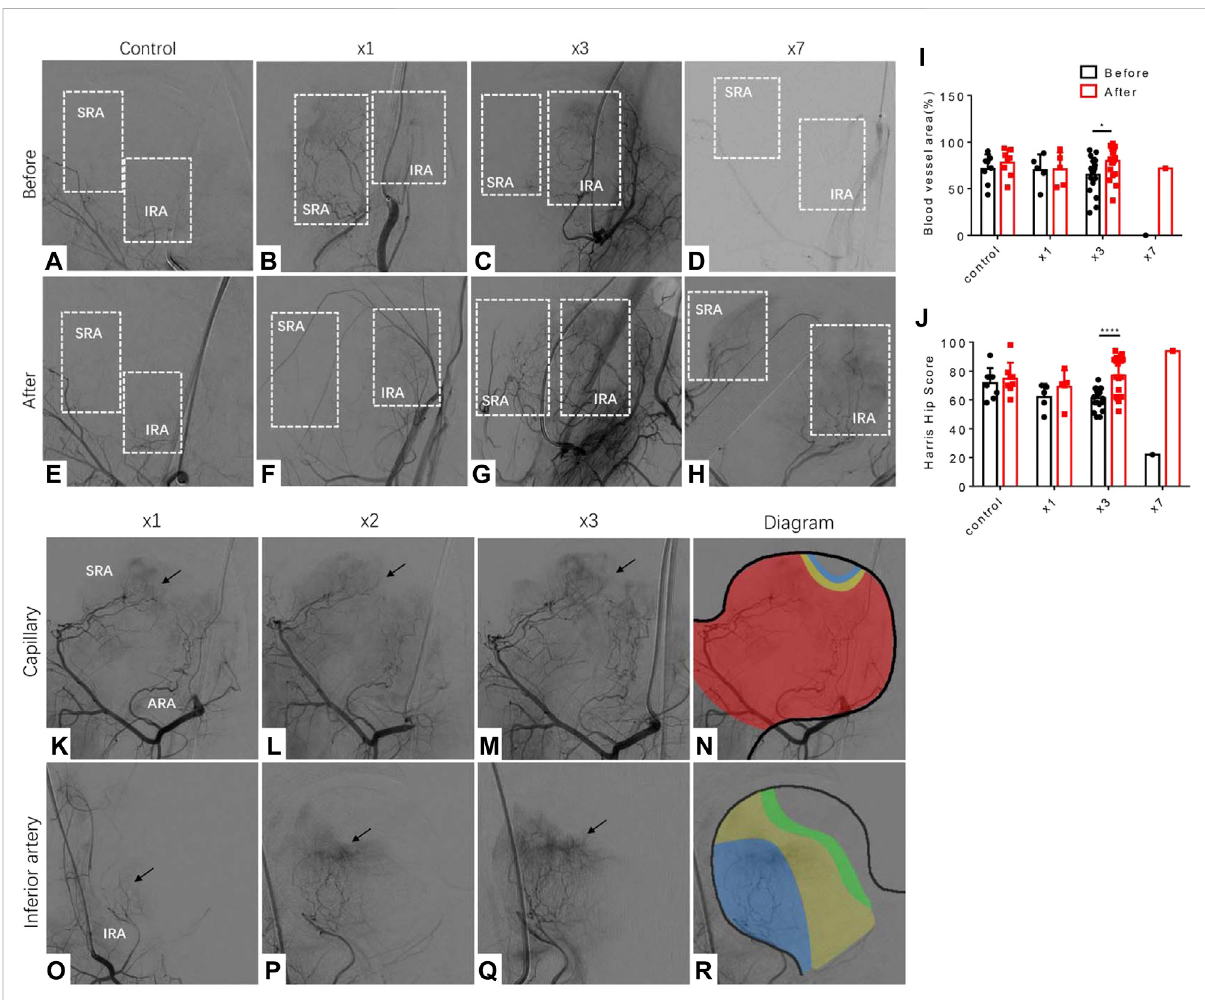
FIGURE 1 Vascularization and promotion of hip function in FHN patients received multiple LPCs infusion treatments. (A – D) DSA images perform the branchesofthemedialcircum fl exarterybeforetreatmentindifferentgroups(zero-time,onetime,threetimes,seventimes,respectively).Thewhite rectangle selects the area where distribute the branches of the medial circum fl ex artery or should be. SRA: superior retinacular artery, IRA: inferior retinacularartery. (E – H) DSAimages perform thebranchesofthemedial circum fl exarteryafter treatment. Thewhiterectangleselects thearea where the new branches of the medial circum fl ex artery growth or will be. (I) The quantitative analysis of the blood vessel area measured in femoral head in different groups before and after treatment. (J) The quantitative analysis of Harris Hip score measured in four different groups before and after treatment. (K – N) Representative DSA images that represent the capillary network priority regeneration type along with three times treatment. Red area: original blood area; Yellow area: regenerated area after the fi rst treatment; Blue area: regenerated area after the second treatment. (O –